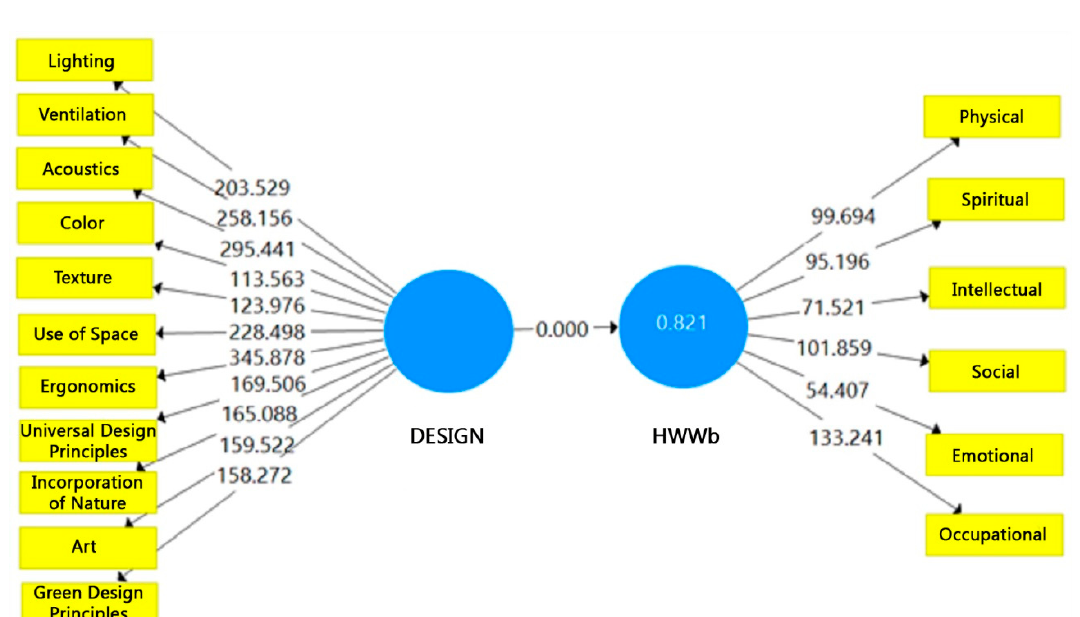
Figure 2. Measurement Model.